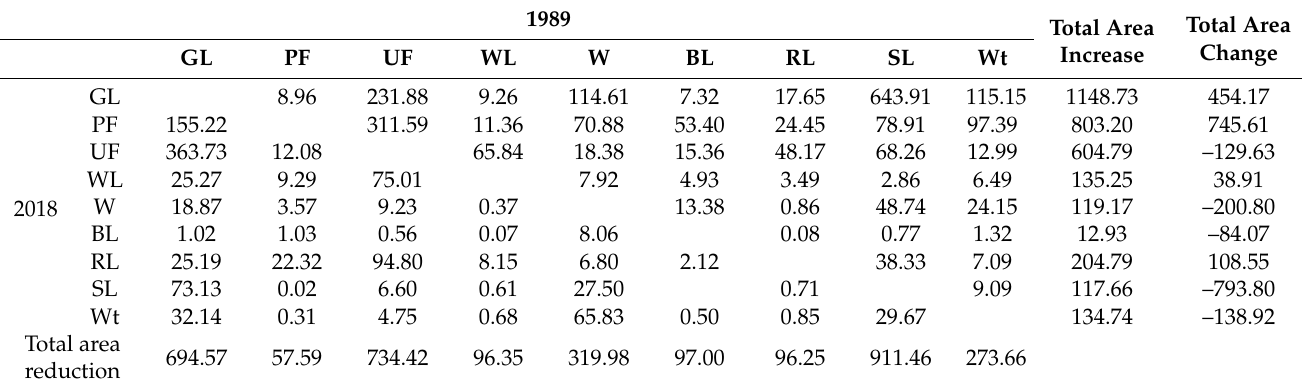
Table 1. Land use type transfer matrix from 1989 to 2018 (km 2